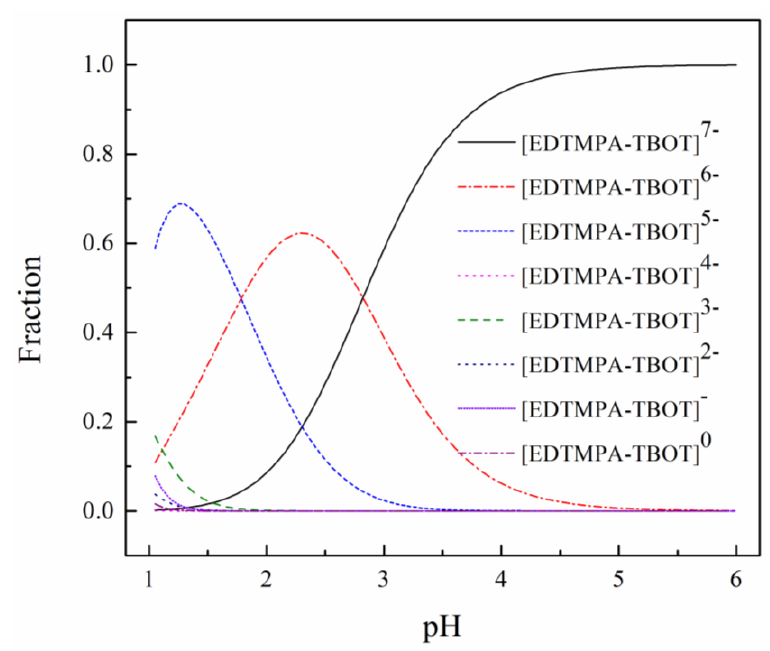
Figure 6. Distribution of the species for the EDTMPA-TBOT ligand as a function of pH by HySS2009.